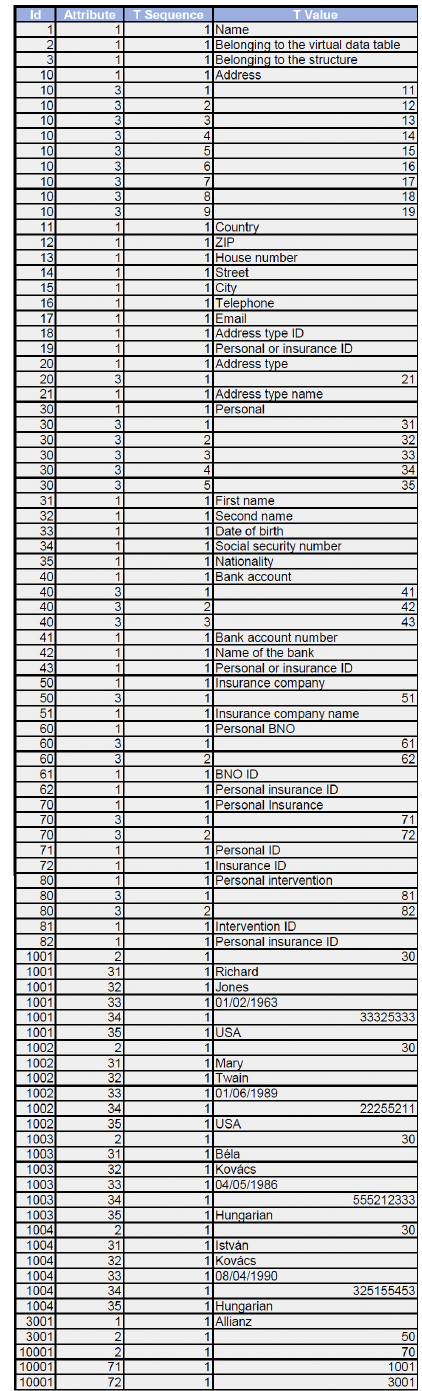
Figure 7. Physical data storage